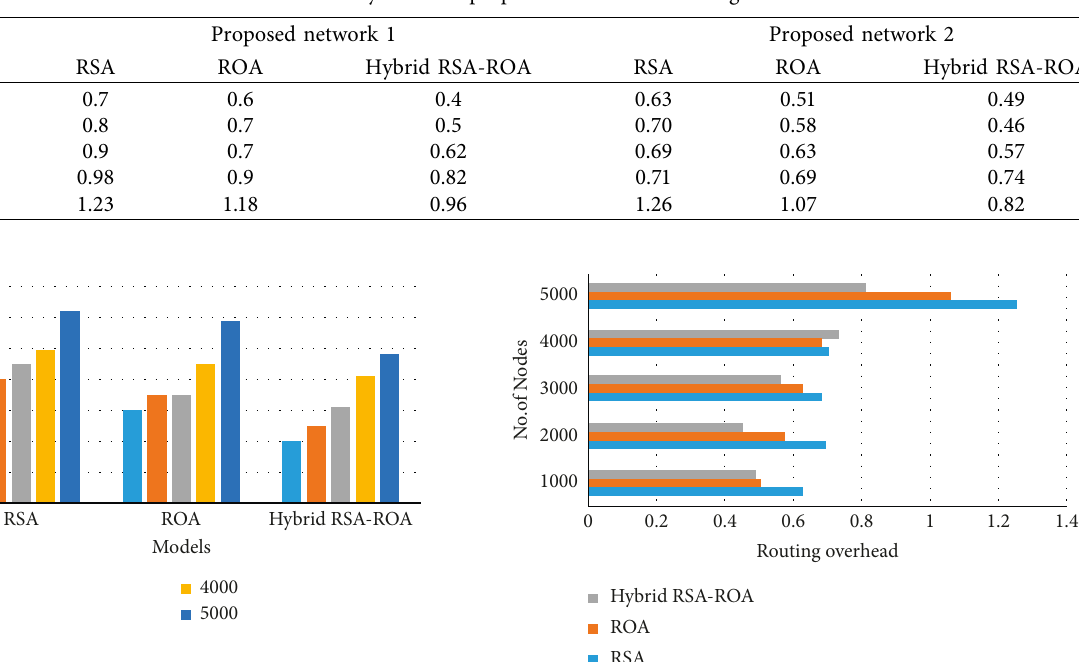
Figure 7: Graphical representation of the proposed method in terms of routing overhead for network 1.